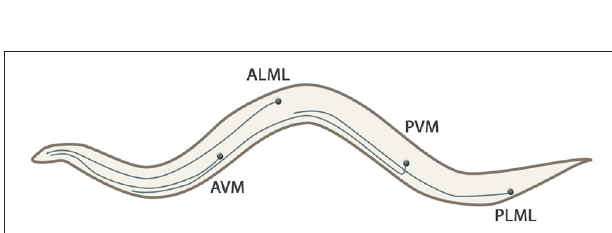
FIGURE 3 | Touch receptors (ALML, ALMR, AVM, PLML, PLMR, and PVM) of the C. elegans that extend their processes along the body of the worm. Note that right neurons (ALMR and PLMR) are not represented because they are symmetrical to their left couples.